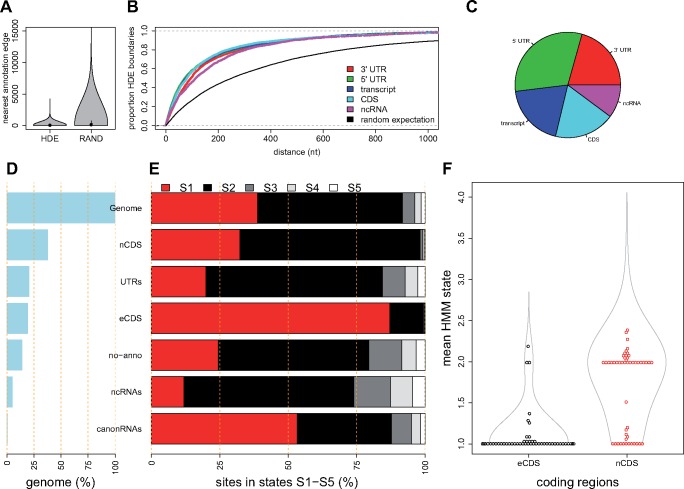
Functional Landscape by Annotation Type. Parts (A–C) show that the boundaries of HMM-Defined Elements (HDEs) are aligned to, or close to, the boundaries of existing annotations, as defined in legend at top right. The random expectation is derived from the same number of elements of the same lengths, placed at random on the genome. (A) HDEs have a smaller distance to the nearest annotation than random expectation. (B) For all HDE edges we show a cumulative density plot of nearest annotation type, including 5′/3′-UTRs, transcripts (transcription start/stop positions), coding sequences (amino-acid encoding regions, CDS), noncoding RNAs (ncRNAs), with lines colored according to the legend at right. (C) HDEs fell closest to a variety of annotations. The pie chart shows the proportions of nearest annotations, indicating a bias toward defining 5′-UTR edges. There were subtle differences between states S1, S2, and S3 in this respect (not shown). The HMM defined five states based on Hermes transposon insertions. State 1 (S1) refers to the most important regions, with the least insertions, and state 5 (S5) with the highest density of insertions. (D) Percentage of Schizosaccharomyces pombe genome covered by various annotation types: entire genome (100%), essential protein-coding regions (eCDS), protein-coding nonessential regions (nCDS), canonical noncoding RNAs (snRNAs, snpRNAs, tRNAs, rRNAs, canonRNAs), 5′/3′-UTRs (UTRs), noncoding RNAs (ncRNAs), and unannotated regions (no-anno). (E) Proportions of each annotation type in the five states: S1 (red), S2 (black), S3 (dark gray), S4 (light gray), and S5 (white). (F) Mean HMM states for essential (eCDS) and nonessential (nCDS) coding regions. Representative 50 points are shown for each type to indicate that most essential coding regions have mean state ∼1 (85% mean state <1.2).